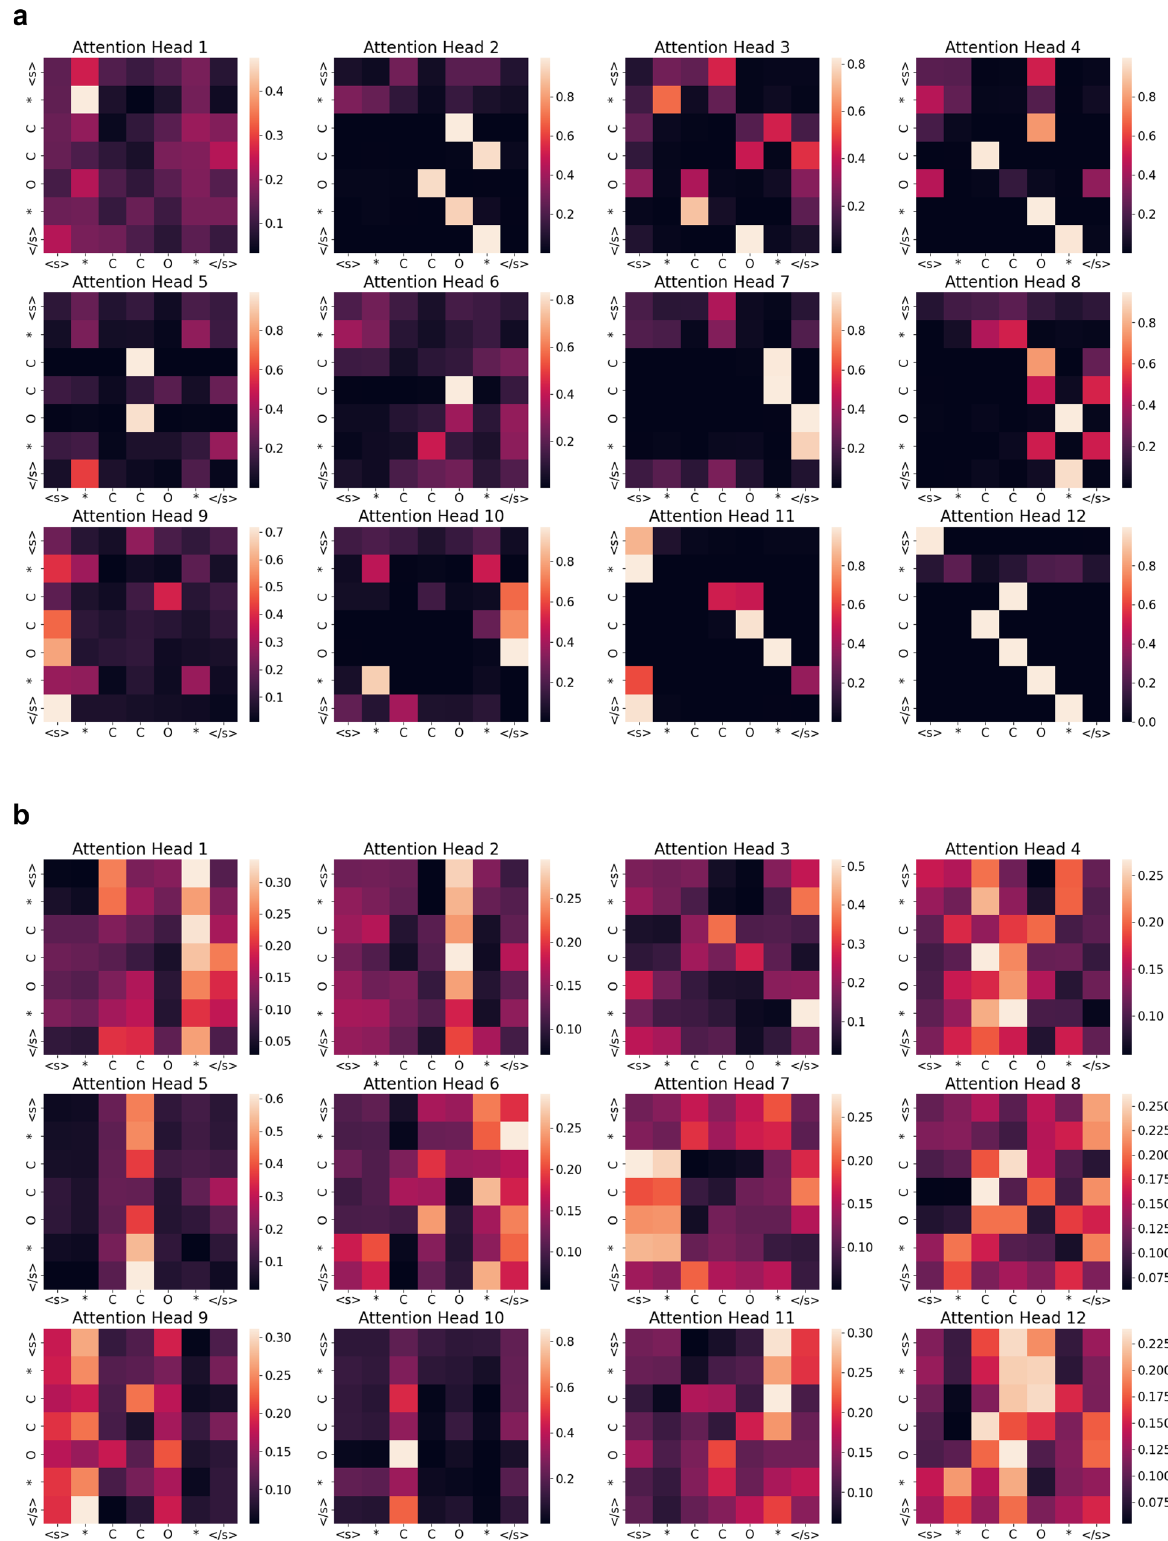
Fig. 5 Visualization of attention scores from pretrained TransPolymer. a Attention scores in the fi rst hidden layer. b Attention scores in the last hidden